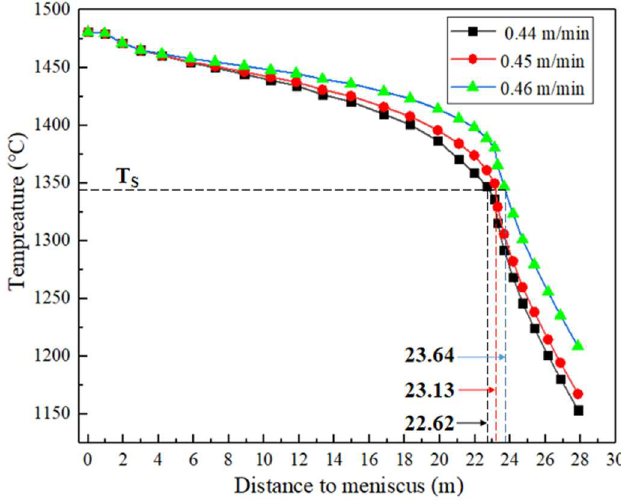
Figure 5. Effect of casting speed on the final solidifying end.